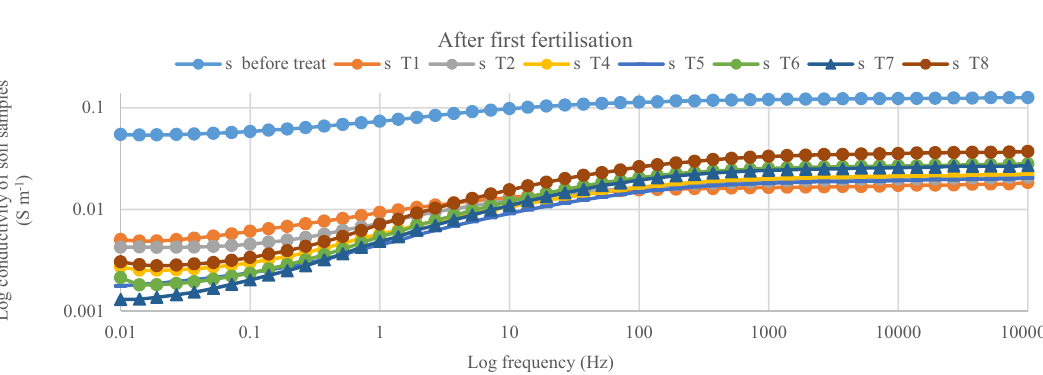
Figure 6. Conductivity of soil samples after first fertilization (20 days after transplanting) within 0.01 Hz and 100